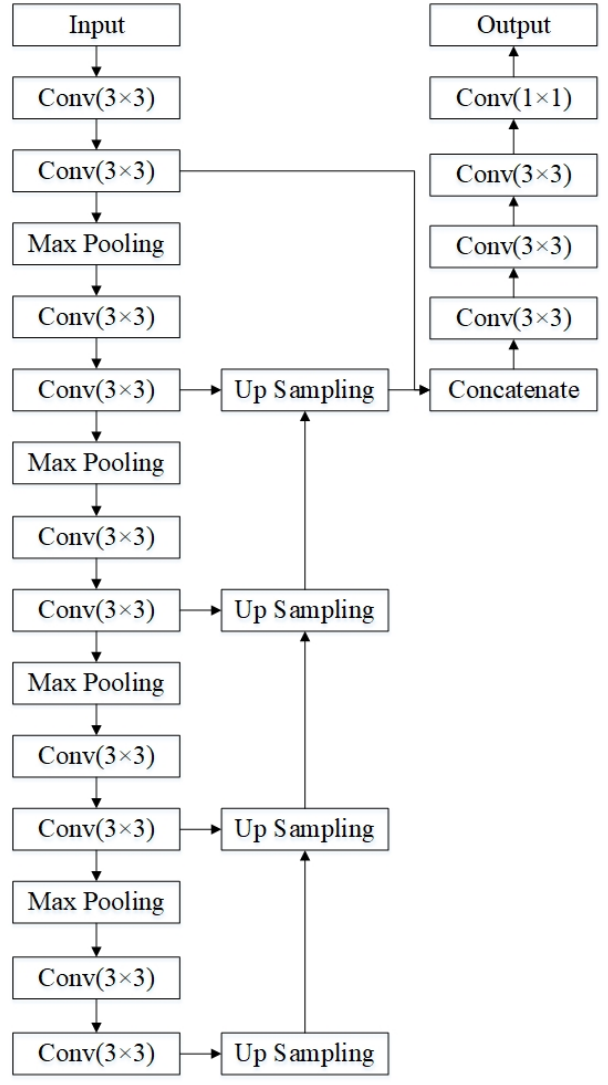
Figure 4. The proposed self-information extraction structure. The self-information of the input data is captured by a multi-stage feature extraction structure and further generates the output using fused multi-stage feature and convolutional layers.